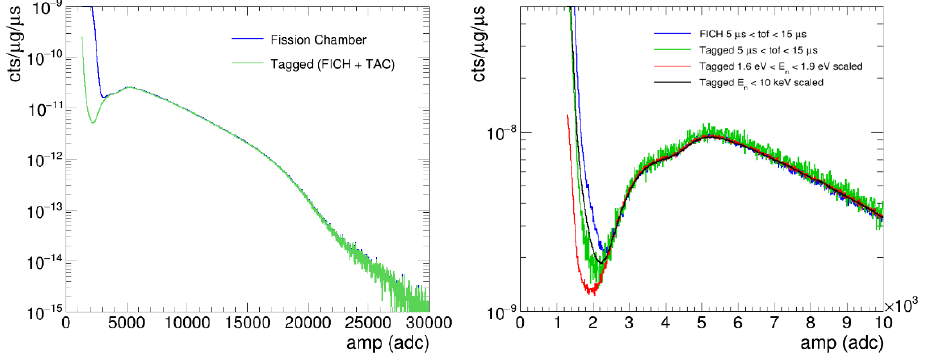
Fig. 7. Comparison of the amplitude spectra of the FICH and tagged counts: for 20 meV < E n < 10 keV (left panel), α -FF separation for various conditions on E n or TOF (right panel).